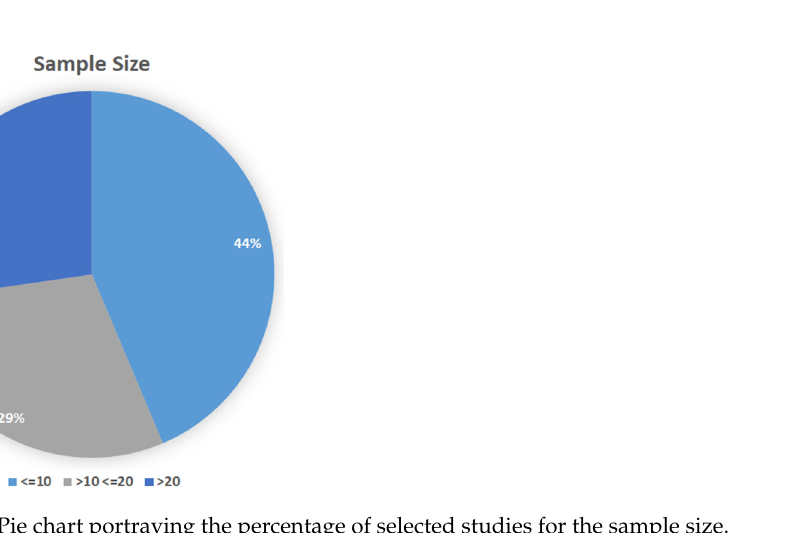
Figure 6. Pie chart portraying the percentage of selected studies for the sample size.